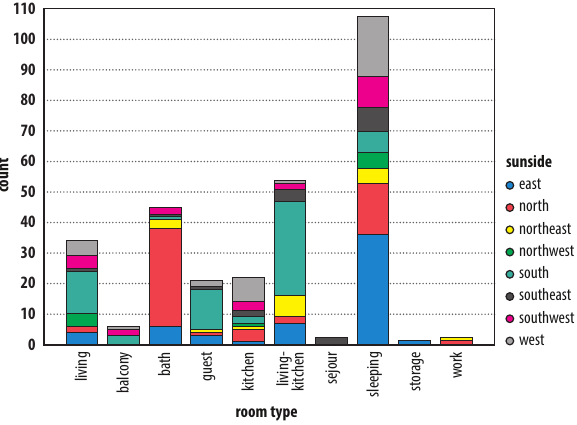
Figure 1. Functional use and orientation of housing rooms in Germany – People prefer to spend dinner in a sunny living